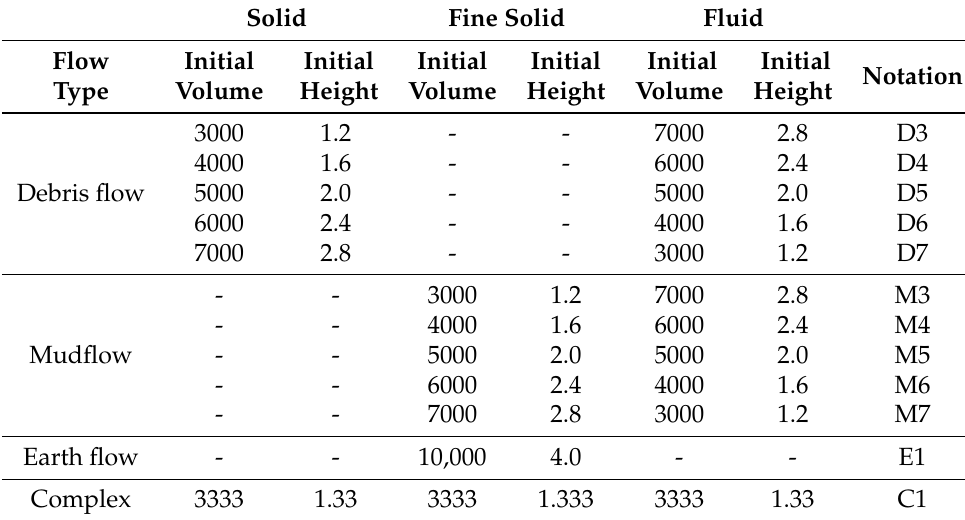
Table 2. Notation for various analysis